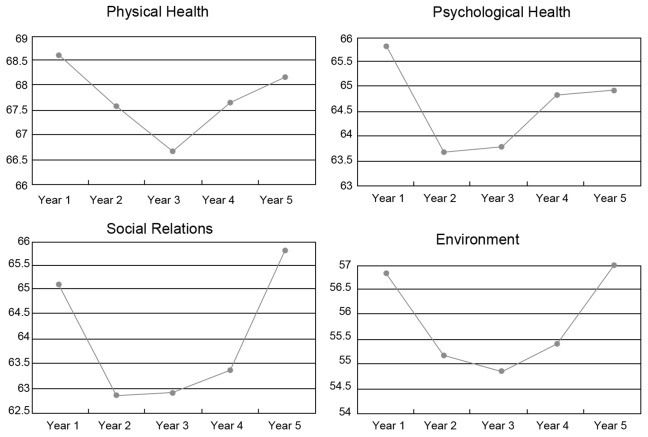
Scores of each domain for clinical medicine.